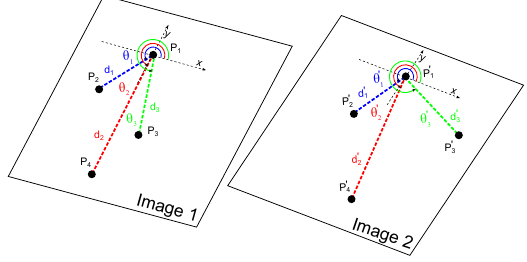
Figure 12. The (P 2 ↔ P’ 2 ) and (P 4 ↔ P’ 4 ) are correct matches in image 2 with respect to image 1 but (P 3 ↔ P’ 3 ) is an incorrect match due to different value of θ 3 .